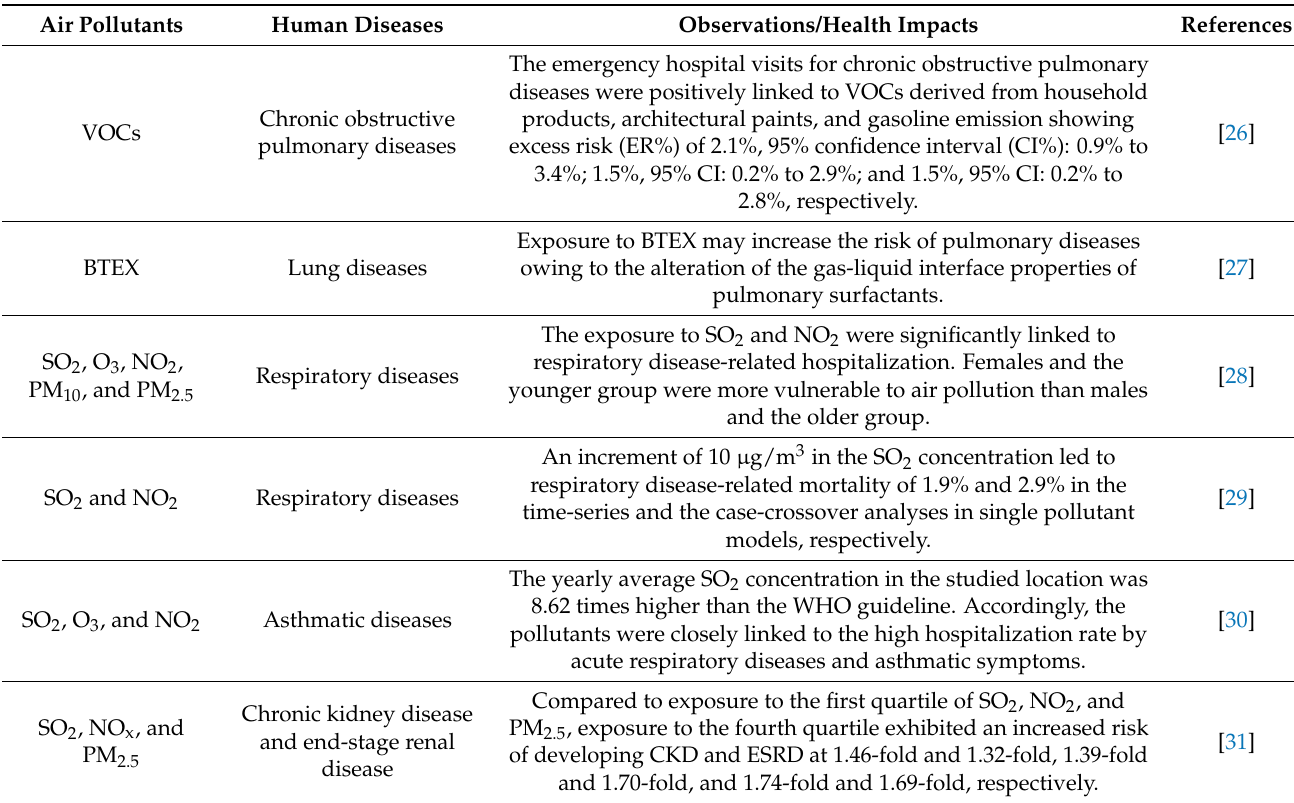
Table 1. Human diseases associated with air